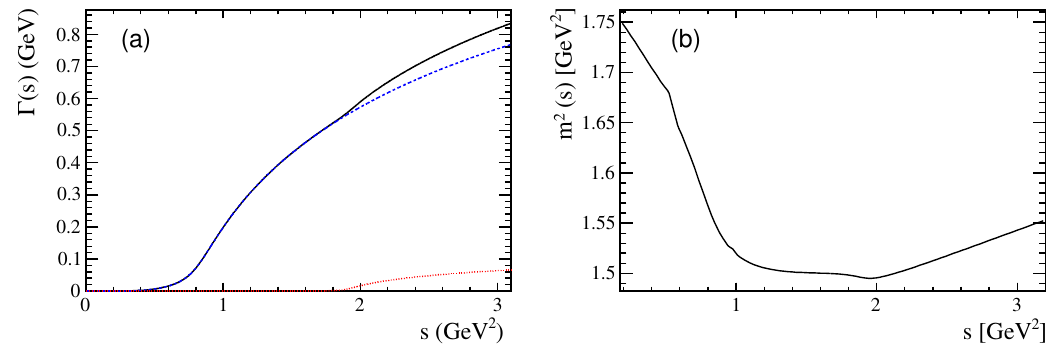
Figure 4 . Energy-dependent width (a) and energy-dependent mass (b) for the a 1 (1260) reso- nance. The total width is shown in black (solid), while the partial widths (cid:0) (3) (cid:0) (3) ( s ) are shown in blue (dashed) and red (dotted), a 1 (1260) ! K (cid:22) K(cid:25)